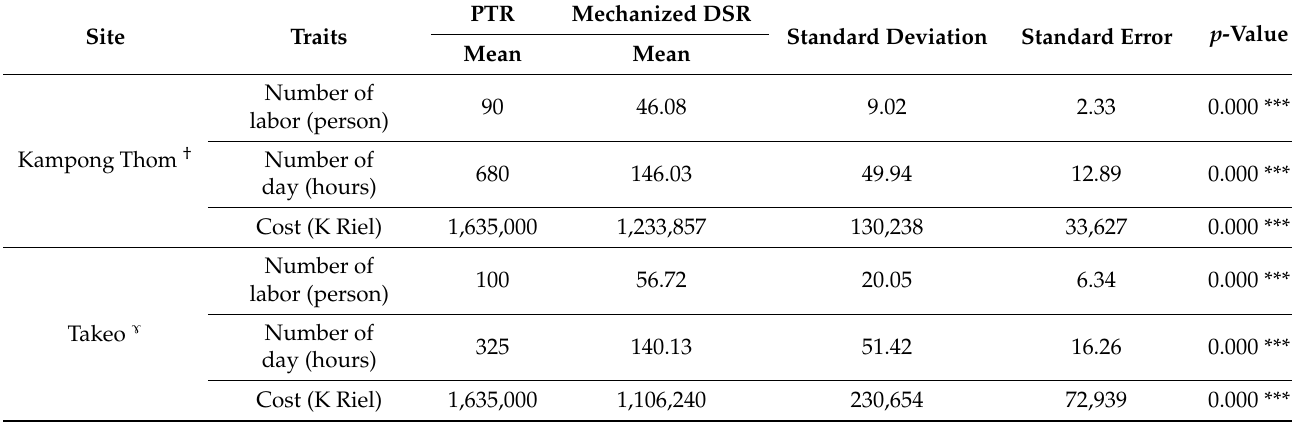
Table 2. Labor saving under mechanized DSR compared to PTR at Kampong Thom and Takeo sites, Cambodia. Site